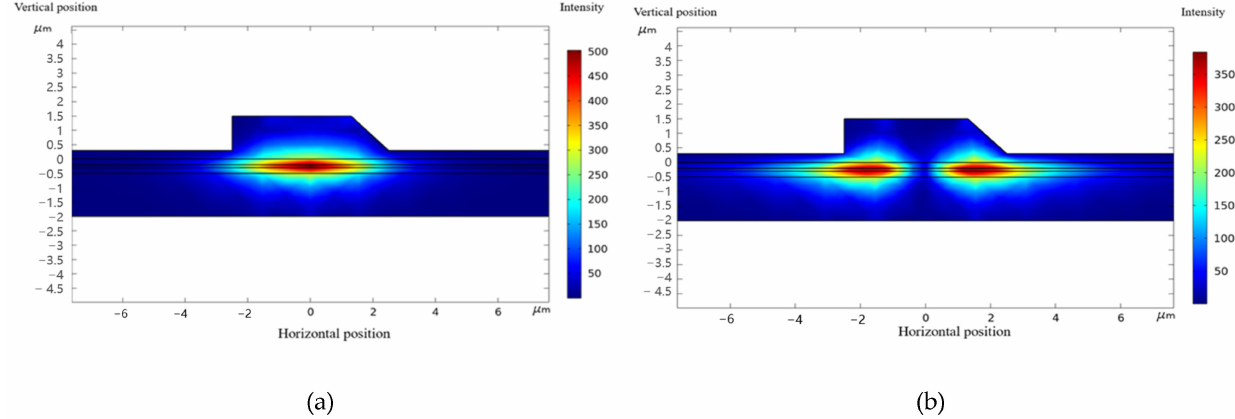
Figure 2. Diagram of the calculated mode distribution ( a ) the distribution of fundamental mode; ( b ) the distribution of second-order